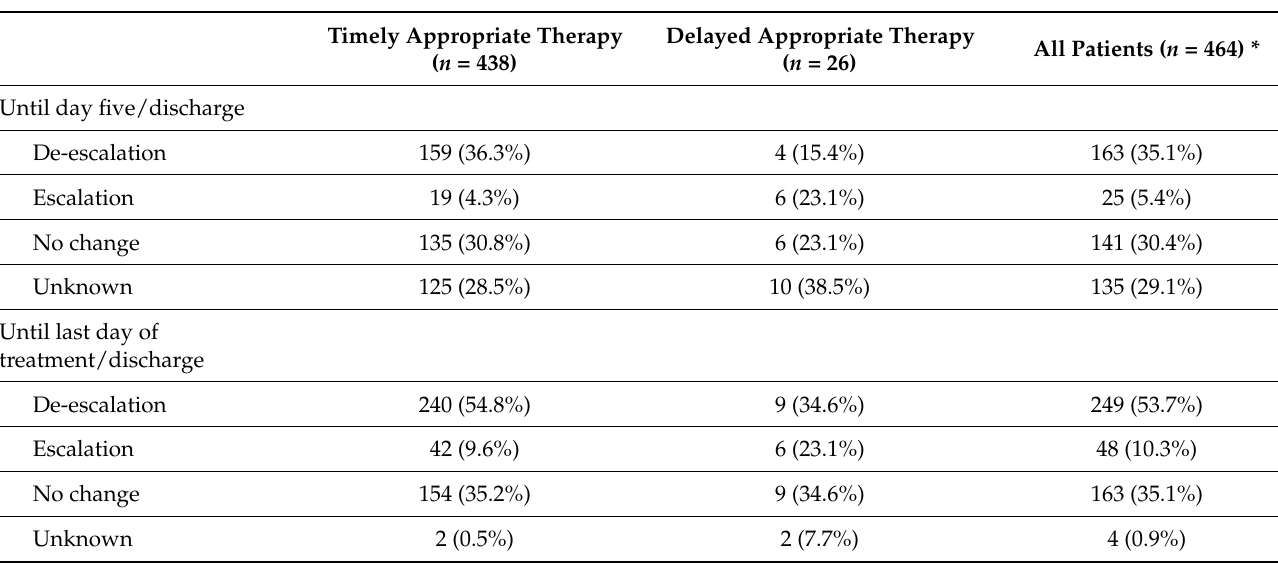
Table 2. Patterns of antibiotic escalation and de-escalation, by timeliness of initial antibiotic